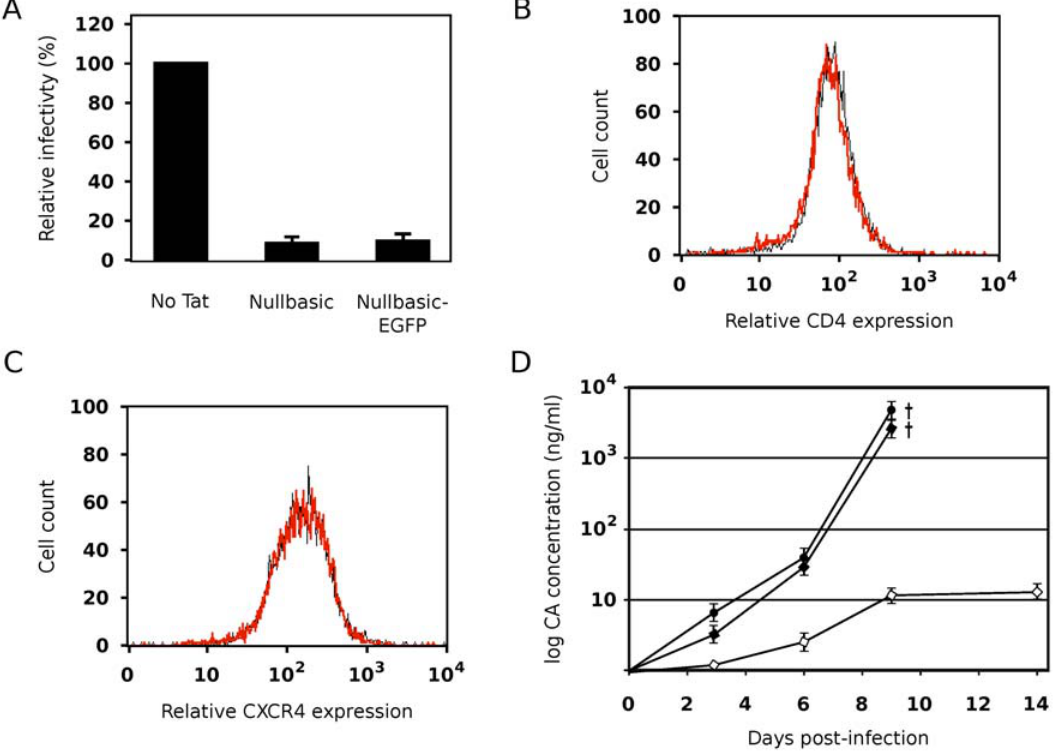
Figure 8. Expression of Nullbasic-EGFP in permissive target cells suppresses HIV-1 infection and spread. ( A ) The ability of Nullbasic- EGFP to inhibit HIV-1 infectivity was compared to Nullbasic in a MAGI assay similar to Figure 7A (using a 1:2 molar ratio only). Columns represent the means and standard deviations of three independent experiments and are expressed as a percentage of the ‘‘No Tat’’ (pcDNA3.1 + co-transfected) sample. ( B ) Cell surface expression of transgenic CD4 receptors was quantitated in MAGI (black) and MAGI/Nullbasic-EGFP (red) cells by flow cytometry using an anti-CD4 monoclonal antibody. ( C ) Cell surface expression of endogenous CXCR4 receptors was quantitated in MAGI (black) and MAGI/Nullbasic-EGFP (red) cells by flow cytometry using an anti-CXCR4 monoclonal antibody. ( D ) The MAGI (black circles), MAGI/EGFP (black diamonds) and MAGI/Nullbasic-EGFP (white diamonds) cell lines were infected with equal amounts of pGCH-derived virions (500 ng CA-equivalent per 10 6 cells) before viral replication was monitored over a 14-day period. Log values of virion CA levels measured in the culture supernatants are shown plotted against time. Obelisks ( { ) indicate observations of syncytia and cell death in the MAGI and MAGI/EGFP cell lines at 9 days post- infection. Data points represent the means and standard deviations of triplicate assays in two independent experiments.